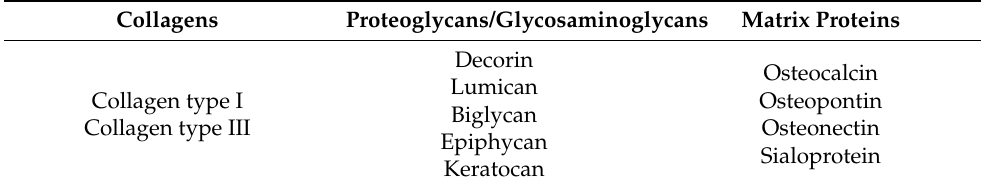
Table 3. The main components of bone organic extracellular matrix